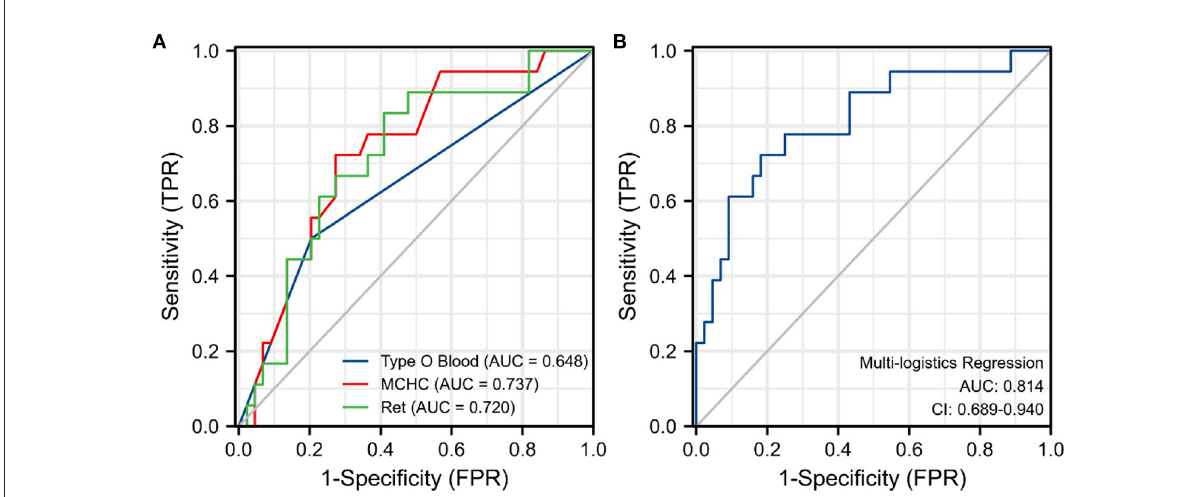
FIGURE2 Receiver operating characteristic (ROC) curve for each significant variable and the multivariate logistic regression model. (A) The ROC curve for three risk indicators. (B) The ROC curve for the multivariate logistic regression model. MCHC, mean corpuscular hemoglobin concentration; Ret, reticulocyte count; TPR, true positive rate; FPR, false positive